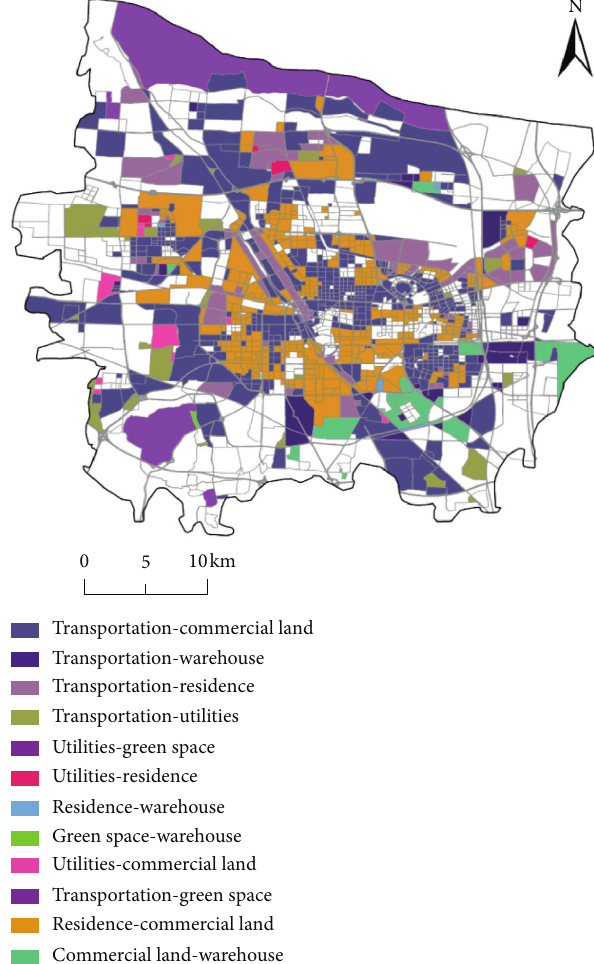
Figure 4: The mixed functional area map of